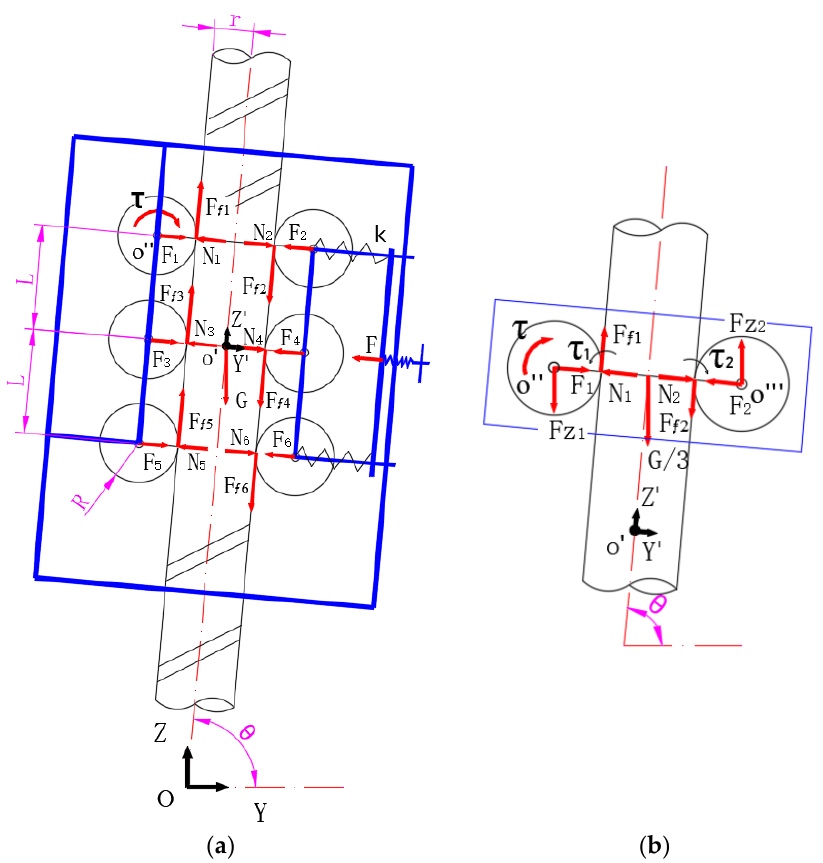
Figure 6. Force diagram of the robot when it has an upward movement trend. ( a ) Force diagram in the YOZ coordinate plane, ( b ) simplified equivalent force diagram.